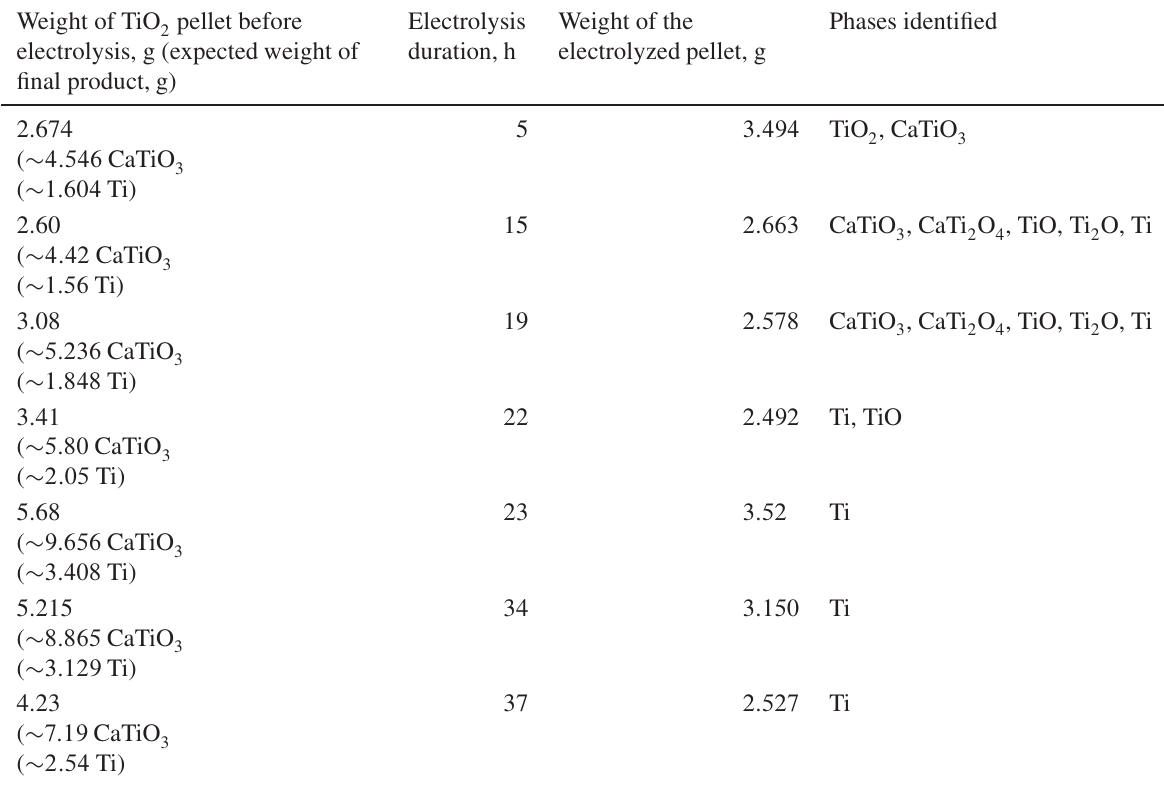
Table 6. Phases obtained after electrolysis of TiO